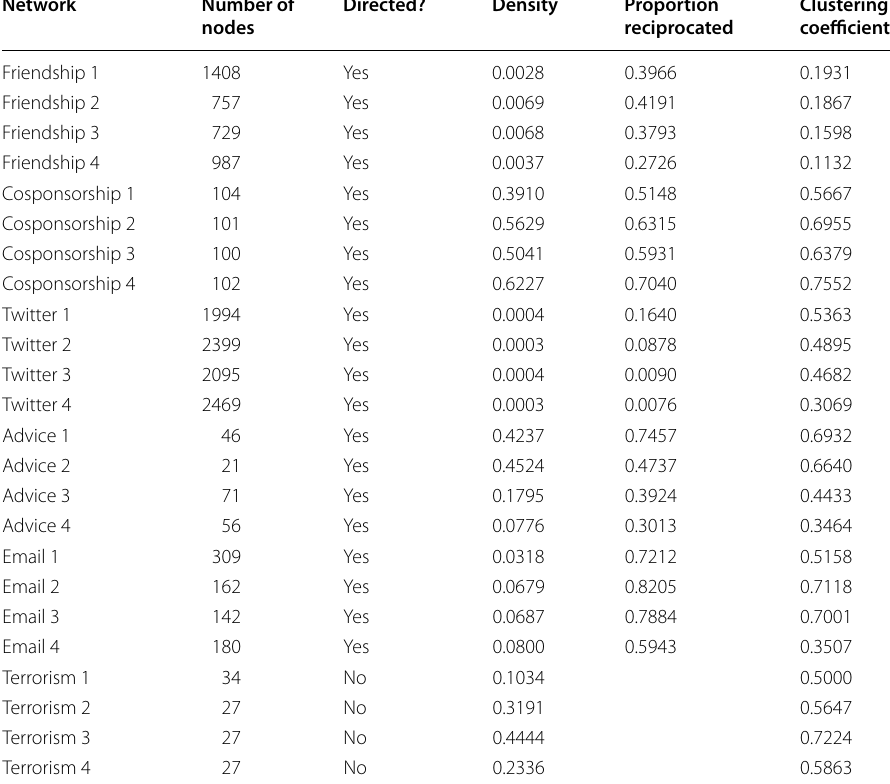
Table 1 Summary of networks and descriptive statistics